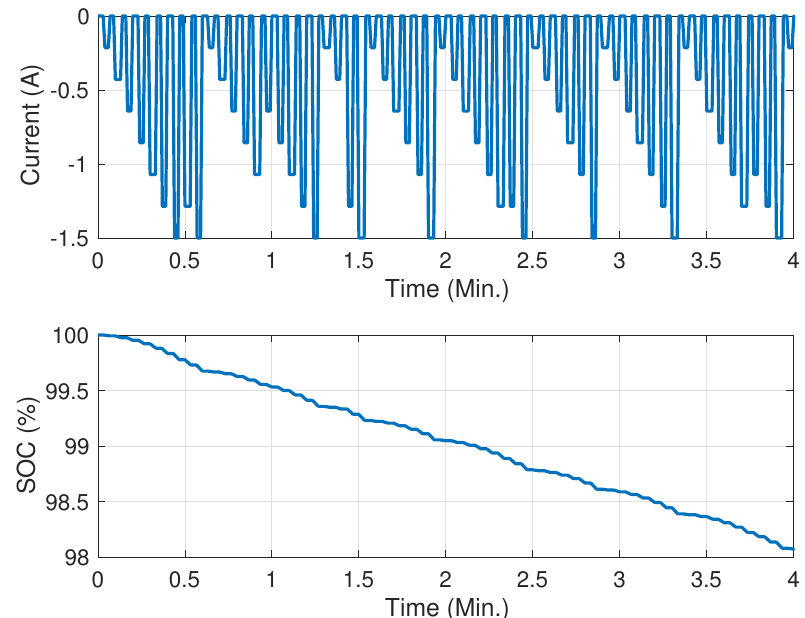
Figure 8. Current profile and corresponding SOC. First four minutes of the true current profile and the corresponding true SOC that is computed using the geometric approach detailed in Figure 3. Only 4 min of profiles are shown; the true profile lasted for 4 h (see Figure 9).